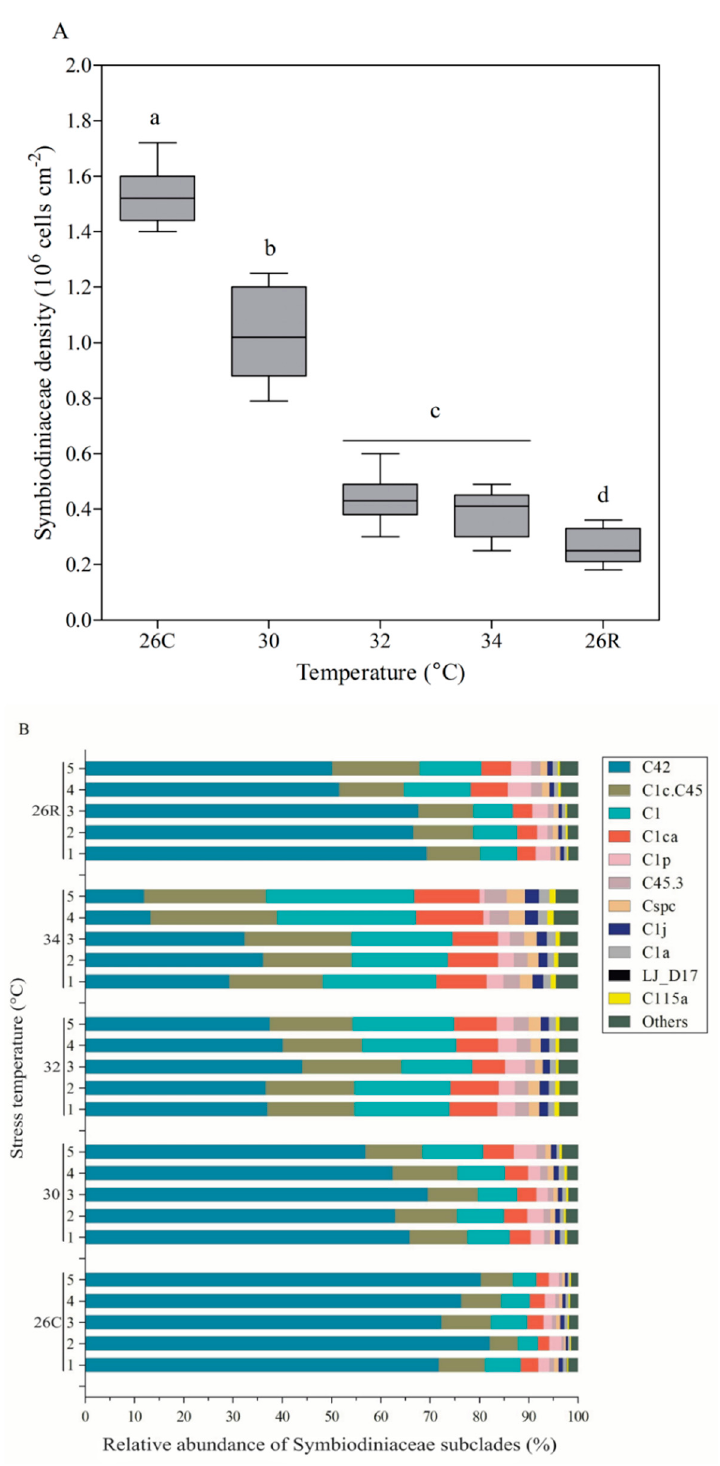
Figure 5. Change in Symbiodiniaceae density ( A ) and ITS2 sequence-based subclade composition ( B ) of Pocillopora sp. at different temperatures. The data in ( A ) are the means ± SEs. “Others” ( B ) represent Symbiodiniaceae subclades whose members have a relative abundance of less than 0.01%. The coordinates 26C and 26R represent the 26 °C control and 26 °C recovery, respectively. Five biological samples ( n = 5) were collected at the last moment of each temperature gradient to measure Symbiodiniaceae density and extract metagenomic DNA. Three replicates of Symbiodiniaceae density data were obtained for each sample. The data were subjected to nonparametric Kruskal–Wallis tests (same letters: no significant difference; different letters: significant difference, p < 0.05).